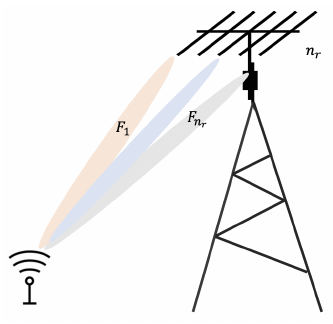
Figure 4. Receiver diversity with SIMO